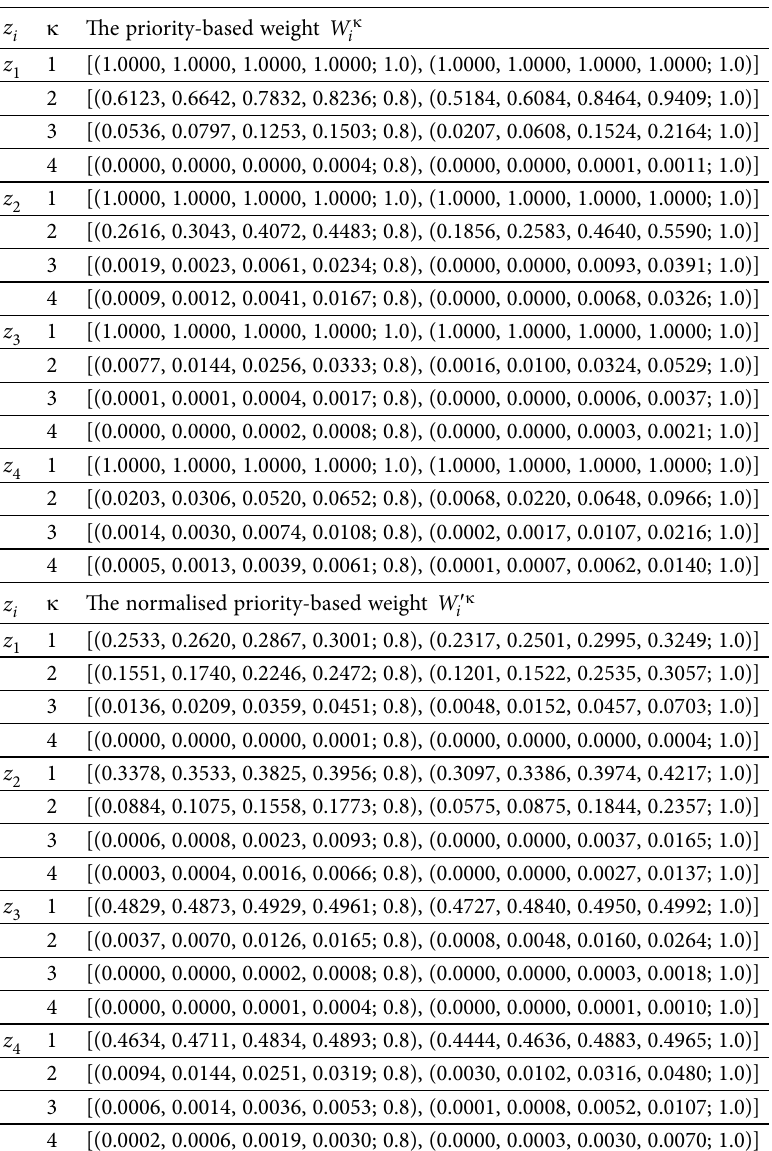
Table 5. Results for the (normalised) priority-based